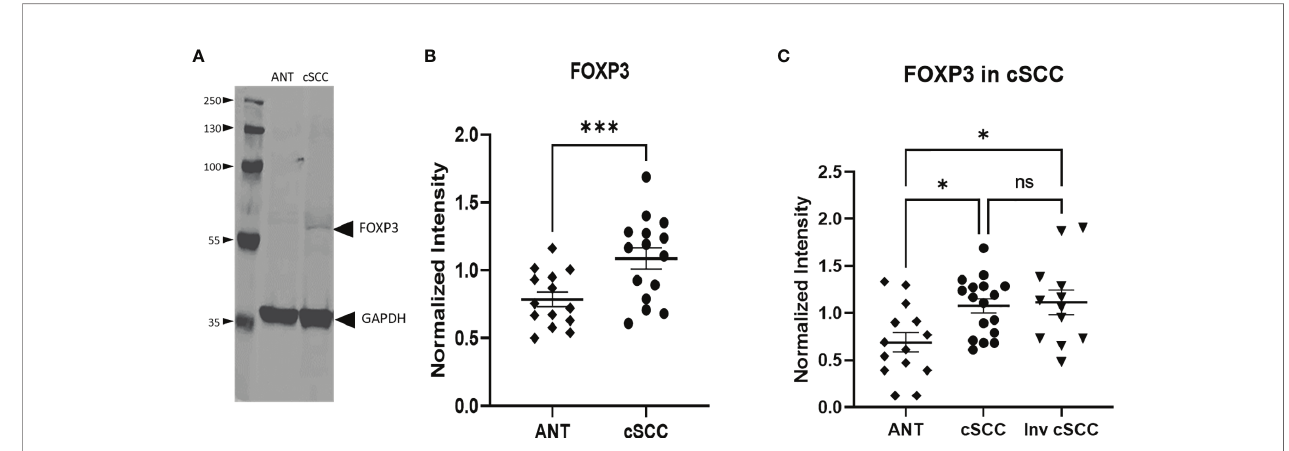
FIGURE 4 | Levels of FOXP3 are Increased in cSCC. Immunoblots detected a band at the expected molecular weight for FOXP3 in both adjacent normal tissue and cSCC samples (A) . The ratio of FOXP3 band intensity normalized to GAPDH intensity was higher in cSCC tissue compared to paired ANT [ (B) , p<0.001] and non- invasive cSCC compared to unpaired ANT but there is no difference between non-invasive and invasive cSCC (C) . (*p<0.05; ***p=0.0001; ns, not signi fi